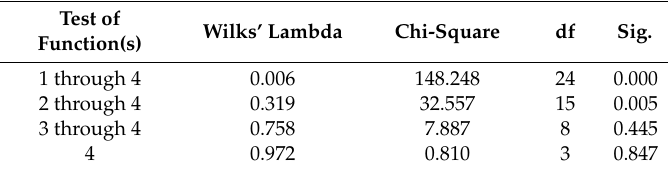
Table A11. Wilks’ Lambda for test of functions 1 through 4.